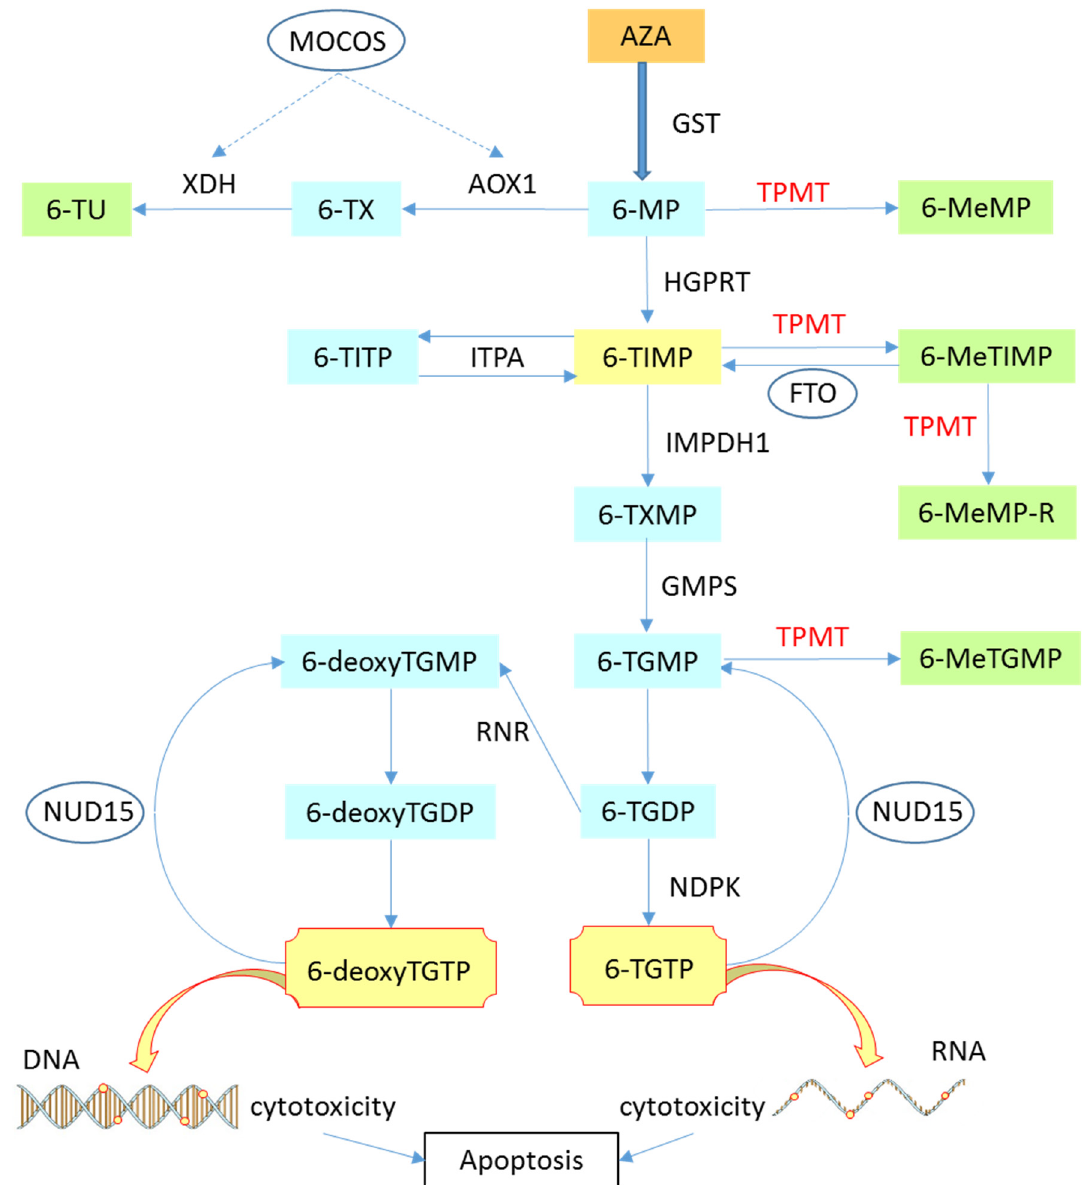
Figure 1. Involvement of TPMT on the thiopurine metabolic pathway. AZA (azathioprine); AOX1 (aldehyde oxidase type 1); FTO (fat mass and obesity associated); GST (gluthation s-transferase); GMPS (guanosine monophosphate synthetase); HGPRT (hypoxanthine guanine phosphoribosyl transferase); IMPDH1 (inosine 5-monophosphate deshydrogenase type 1); IPTA (inosine triphosphate pyrophosphatase); MOCOS (molybdenum cofactor sulfurase); NDPK (nucleotide diphosphate kinase); NUD15 (nucleoside diphosphate linked moiety X type 15); RNR (ribonucleotide reductase); TPMT (thiopurine s-methyltransferase); XDH (synonym-Xanthine oxidase); 6-MP (6-mercaptopurine); 6-MeMP (6-methyl-mercaptopurine); 6-MeMPR (6-methyl-mercaptopurine ribonucleotide); 6-MeTGMP (6-methyl-thioguanine monophosphate); 6-MeTIMP (6-methyl-thioinosine monophosphate); 6-deoxyTGMP (6-deoxy-thioguanine monophosphate); 6-deoxyTGDP (6-deoxy-thioguanine diphosphate); 6-deoxyTGTP (6-deoxy-thioguanine triphosphate); 6-TGMP (6- thioguanine monophosphate); 6-TGDP (6-thioguanine diphosphate); 6-TGTP (6-thioguanine triphosphate); 6-TIMP (6-thioinosine monophosphate); 6-TITP (6-thionosine triphosphate); 6-TXMP (6-thioxanthine monophsphate); 6-TU (thiouric acid); 6-TX (6-thioxanthine).